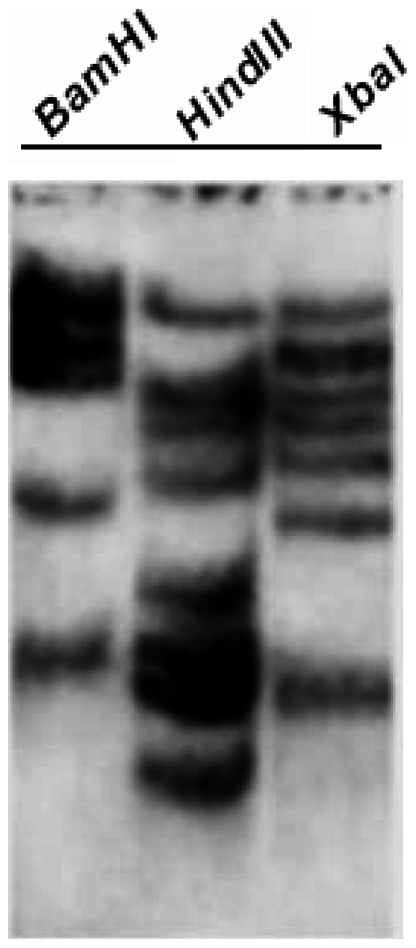
Southern blot analysis of the SsCBF1 gene.
S. lycopersicoides genomic DNA was digested with restriction enzymes BamH I, Hind III, and Xba I. The hybridization was performed using the full-length SsCBF1 as a probe labeled with Digoxin.